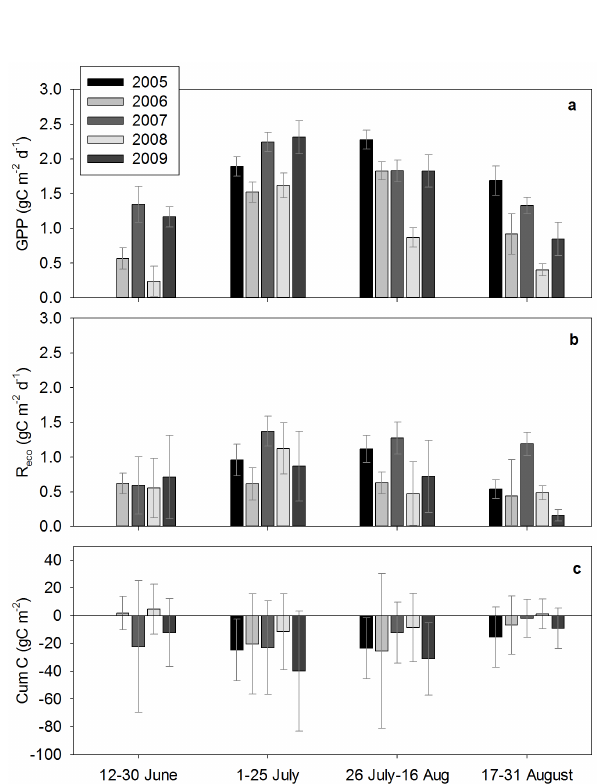
Figure 3. Gross primary production (GPP), ecosystem respiration ( R eco ), and net ecosystem exchange (NEE), for 2005–2009 dur- ing the indicated periods. Error bars for NEE, R eco , and GPP are propagated flux uncertainties estimated by online gap-filling (http: //www.bgjena.mpg.de/~MDIwork/eddyproc/) for the indicated pe-